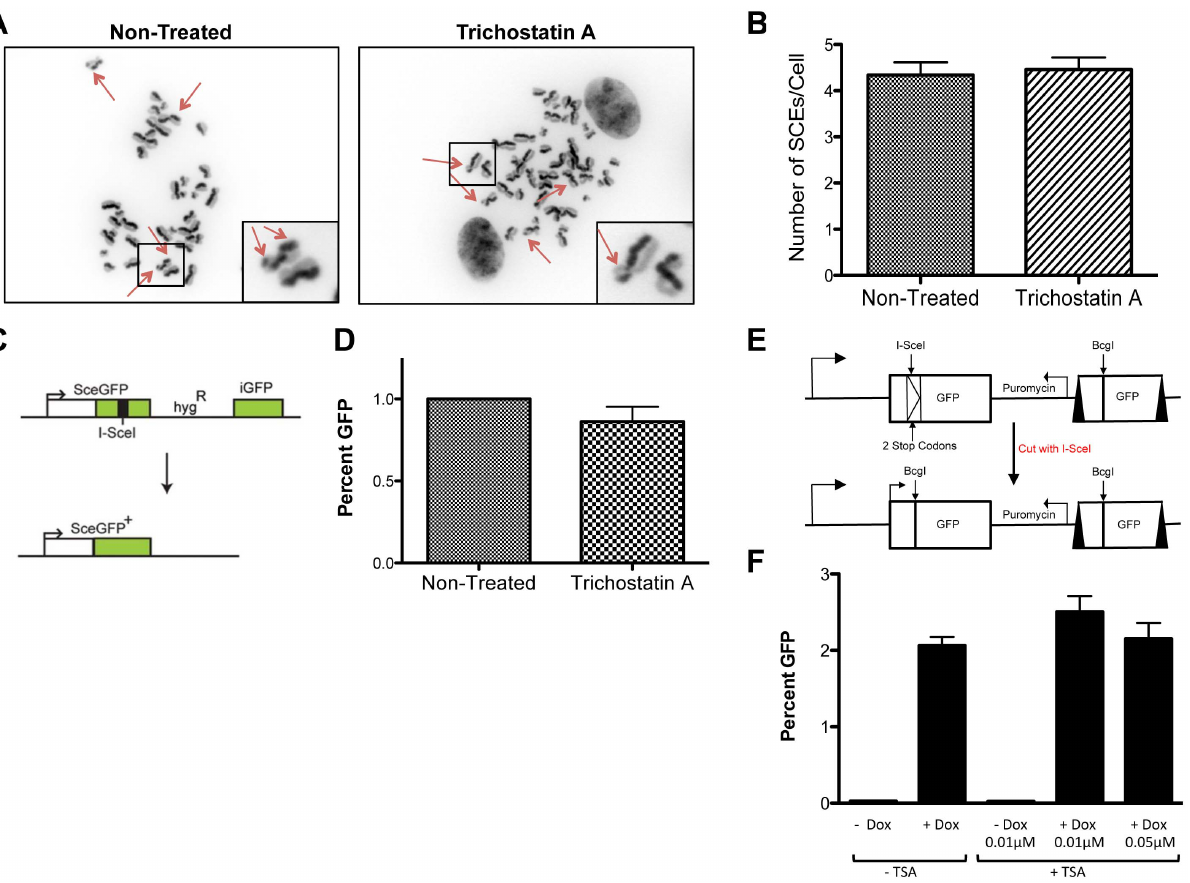
Figure 3. The effect of HDACis on SCE and HR Frequency. (A) RPE cells were treated with 0.2 m M TSA for 48 hr. Representative images of metaphase spreads with arrows indicating SCEs (Magnification: 100 6 ). (Inset) Magnification of the boxed region. (B) The graph represents the average number of SCEs per cell 6 SD following treatment. Non-significance was determined using a two-tailed t-test. (C) Schematic of DR-GFP HR frequency assay. (D) U2OS DR-GFP cells were transfected with pCGA-I-SCEI and then treated with 0.25 m M TSA for 48 hr. The graph represents the average HR frequency 6 SD following treatment determined by FACS analysis. Non-significance was determined using a two-tailed t-test. (E) Schematic of twin reporter DR-GFP HR assay. (F) HeLa iHO4.5GFP cells were pulsed for 24 hr with Dox, washed and chased in the presence of the indicated amounts of TSA. The percentage of GFP-positive cells was determined by FACS analysis. The graph represents the average percent GFP 6 SD. The difference between + Dox/ 2 TSA and + Dox/ + TSA not significant and was determined using a two-tailed